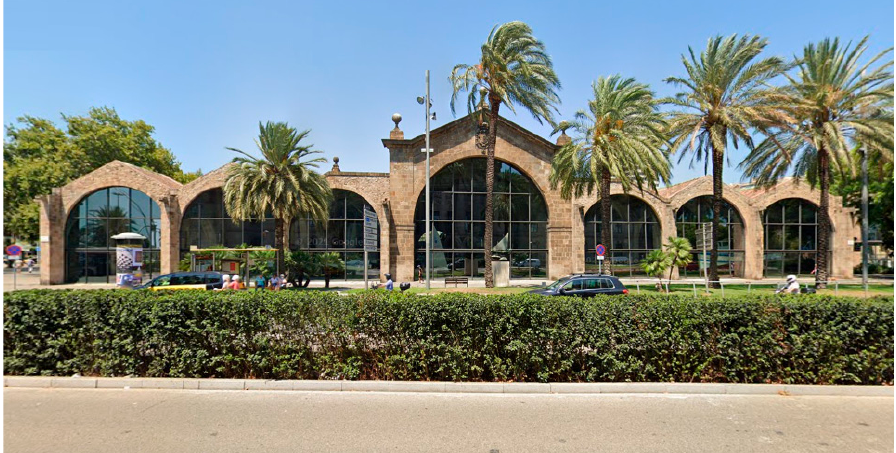
Figure 8. An example application of a laminated glass wall on a historic building of the Maritime Museum of the Barcelona Shipyard from the Medieval period–January 2022. Museum of the Barcelona Shipyard from the Medieval period–January